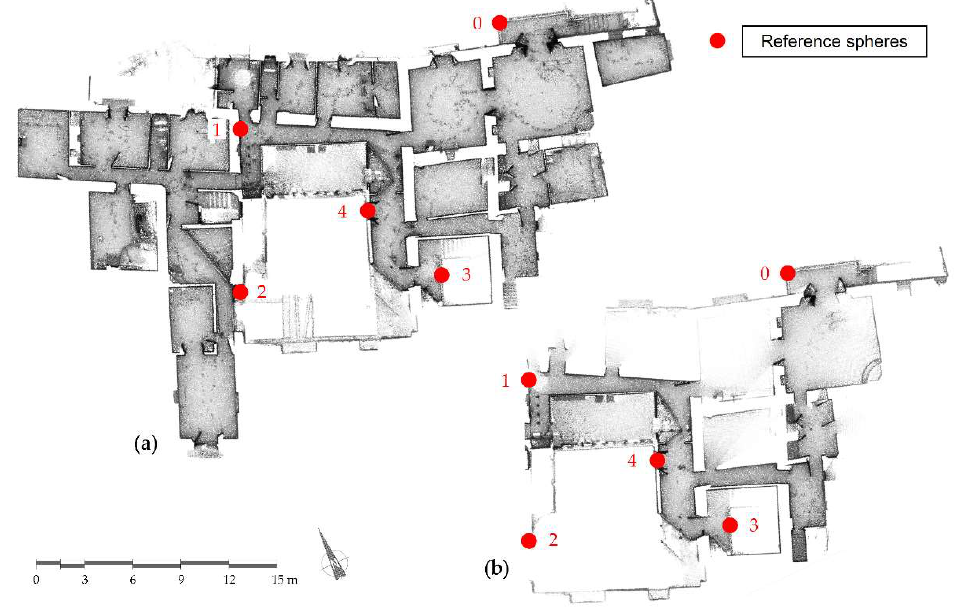
Figure 10. Reference sphere distribution on the first floor for the path 1 ( a ) and path 2 ( b ).